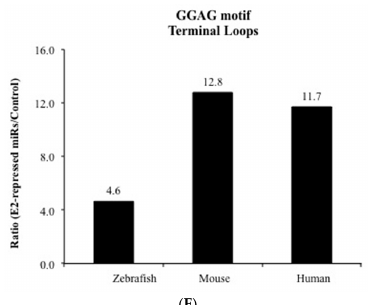
Figure 1. Nucleotide composition of E2-repressed miRNAs. ( A ) Venn diagram showing the overlap between E2-repressed miRNAs of E2-treated zebrafish liver, mouse uterus, and human breast cancer MCF-7 cells; ( B ) Single nucleotide composition of terminal loops of the precursors of E2-repressed zebrafish, mouse, and human miRNAs; ( C ) Single nucleotide composition of stem-loops of E2-repressed zebrafish, mouse, and human miRNAs; ( D ) Dual nucleotide composition of terminal loops of the precursors of E2-repressed zebrafish, mouse, and human miRNAs; ( E ) Dual nucleotide composition of stem-loops of E2-repressed zebrafish, mouse, and human miRNAs; ( F ) Relative enrichment of GGAG motif in terminal loops of the precursors of E2-repressed zebrafish, mouse, and human miRNAs.